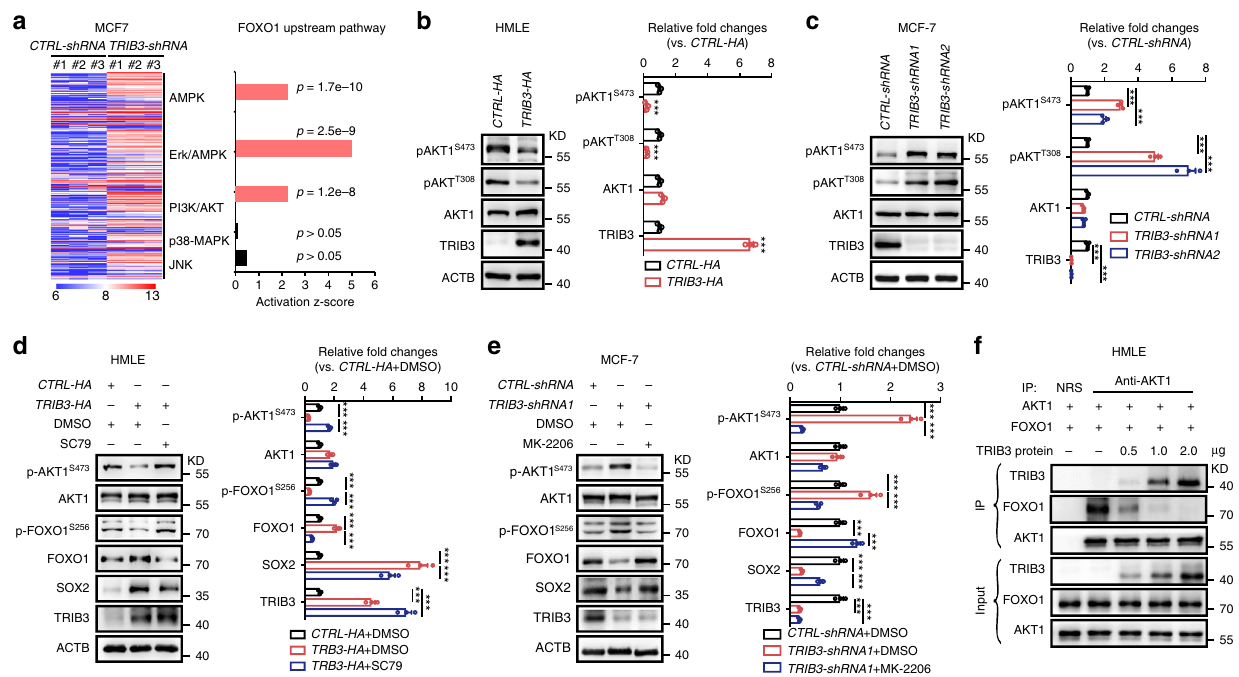
Fig. 6 TRIB3 abrogates the AKT-FOXO1 interaction. a Supervised clustering of MCF7 cells transfected with CTRL-shRNA or TRIB3-shRNA using the log2- transformed values for genes in the FOXO1 upstream pathway, including AMPK, ERK, PI3K, p38, and JNK clustered genes expressed in all samples. Each column represents a separate case. Z -scores from IPA depicting the subnetwork gene expression differences between CTRL-shRNA and TRIB3-shRNA cases. The Z -score heat map depicts the fi ve FOXO1 upstream subnetworks. Each row represents the data for the subnetwork indicated in the right margin. b , c TRIB3 inhibited the activity of AKT1 in BCCs. The indicated stable expression cell extracts were prepared and the levels of the indicated proteins were detected by immunoblotting. d , e The effects of the AKT1 agonist or antagonist for TRIB3-FOXO1-SOX2 axis in BCCs. The indicated cells were treated with the AKT1 agonist SC79 or the antagonist MK2206 for 24 h. Cell extracts were prepared and the levels of the indicated proteins were detected by immunoblotting. f TRIB3 inhibited the AKT1-FOXO1 interaction by binding to AKT1. HMLE cell extracts were IP with an anti-AKT1 Ab and blotted with an anti-TRIB3 or anti-FOXO1 Ab in the presence of the indicated concentration of the TRIB3-GST protein. Data are shown as the mean ± SEM; P > 0.05 was considered not signi fi cant (NS); * P < 0.05, ** P < 0.01, and *** P < 0.001 compared with the vector or CTRL-shRNA group. Source data are provided as a Source Data fi